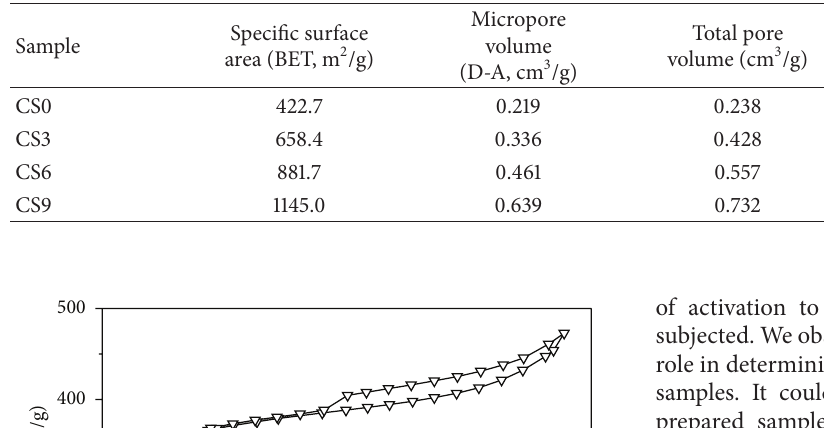
Table 1: Structural characteristics of the studied samples.